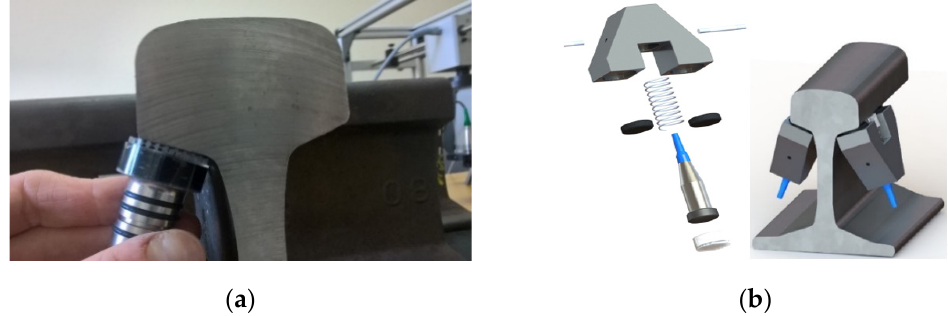
Figure 2. Images of the Rayleigh wave (R-wave) transducers: manual attachment of the Rayleigh wave transducer ( a ), design of a holder that fixes the transducer with constant pressure to the rail ( b ).